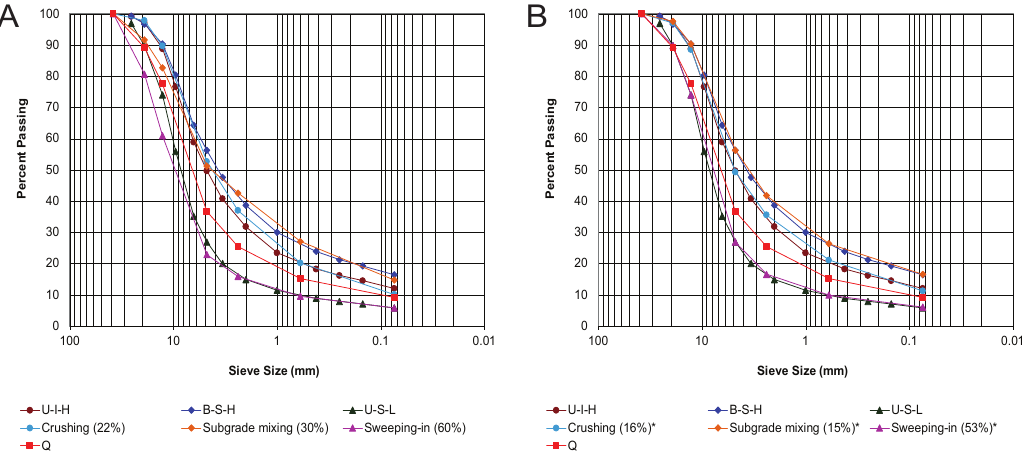
Figure 4. Comparison of the observed particle-size distributions from Rhee et al. [11] with the models of the tra ffi c-induced processes using ( A ) the selected particle size distributions from Figure 4 that are from the initial models and ( B ) the particle size distributions from the modified models to fit the observed particle size distributions. The particle size distributions at U–I–H (up vertical layer, in-between horizontal location, and heavy tra ffi c use), B–S–H (bottom vertical layer, shoulder horizontal location, and heavy tra ffi c use), and U–S–L (up vertical layer, shoulder horizontal location, and light tra ffi c use) were caused by crushing, subgrade mixing, and sweeping-in processes. The particle size distribution from the quarry (Q) is also plotted. The asterisk (*) indicates the modified models to fit the observed particle size distributions. Details on the particle size distributions for the modified models are shown in Tables